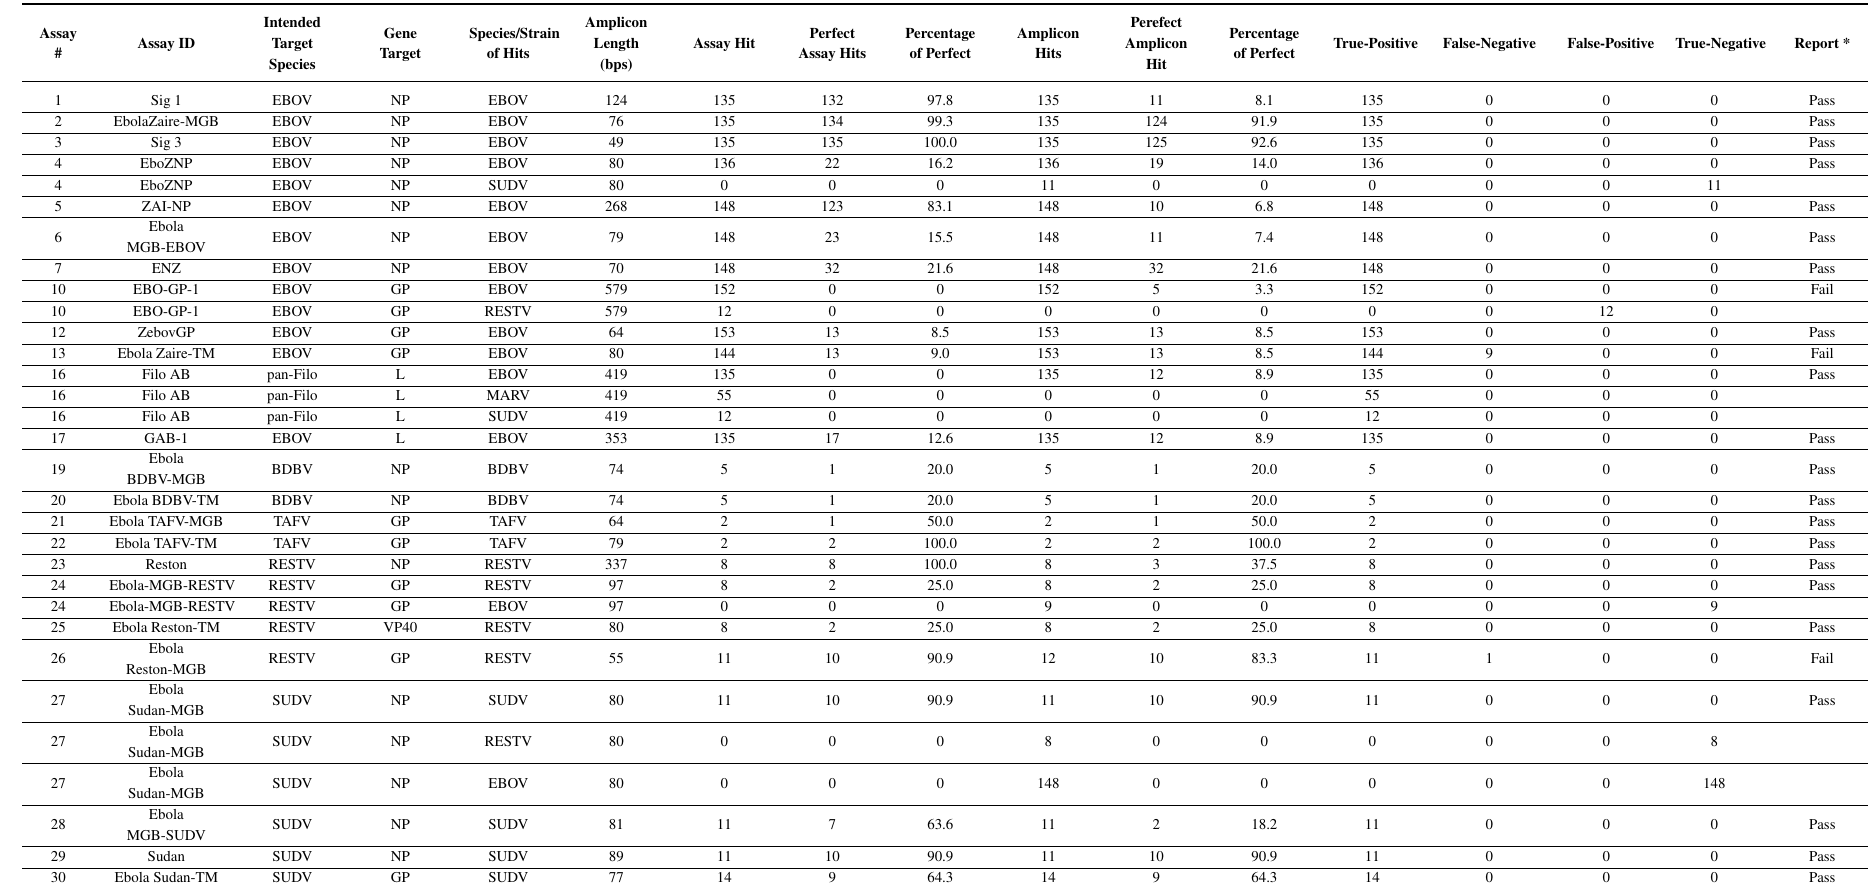
Table 1. PCR Signature Erosion Tool (PSET) analysis of ebolavirus PCR assay